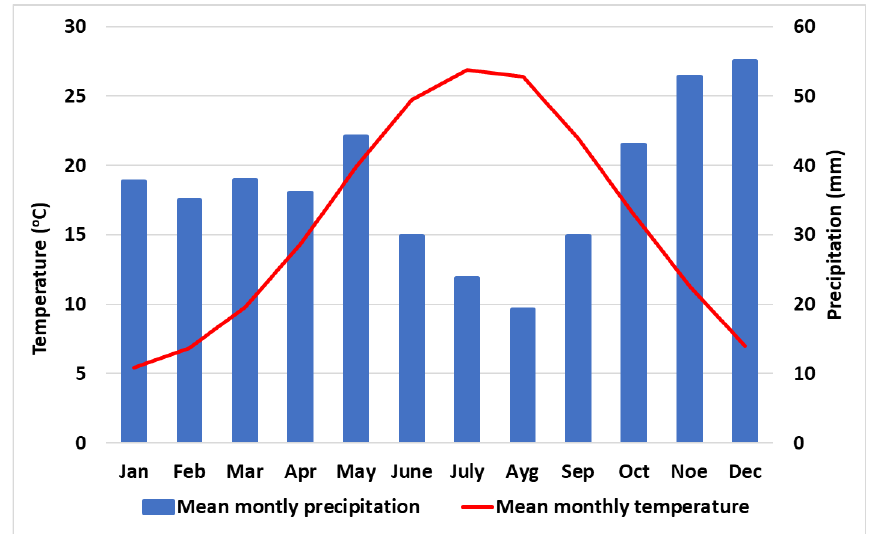
Figure 2. The climate characteristics of Thessaloniki (HNMS 2020). Bangouls and Gaussen Rain- Temperature diagram. The dry-thermal period begins at late May and ends at early October.